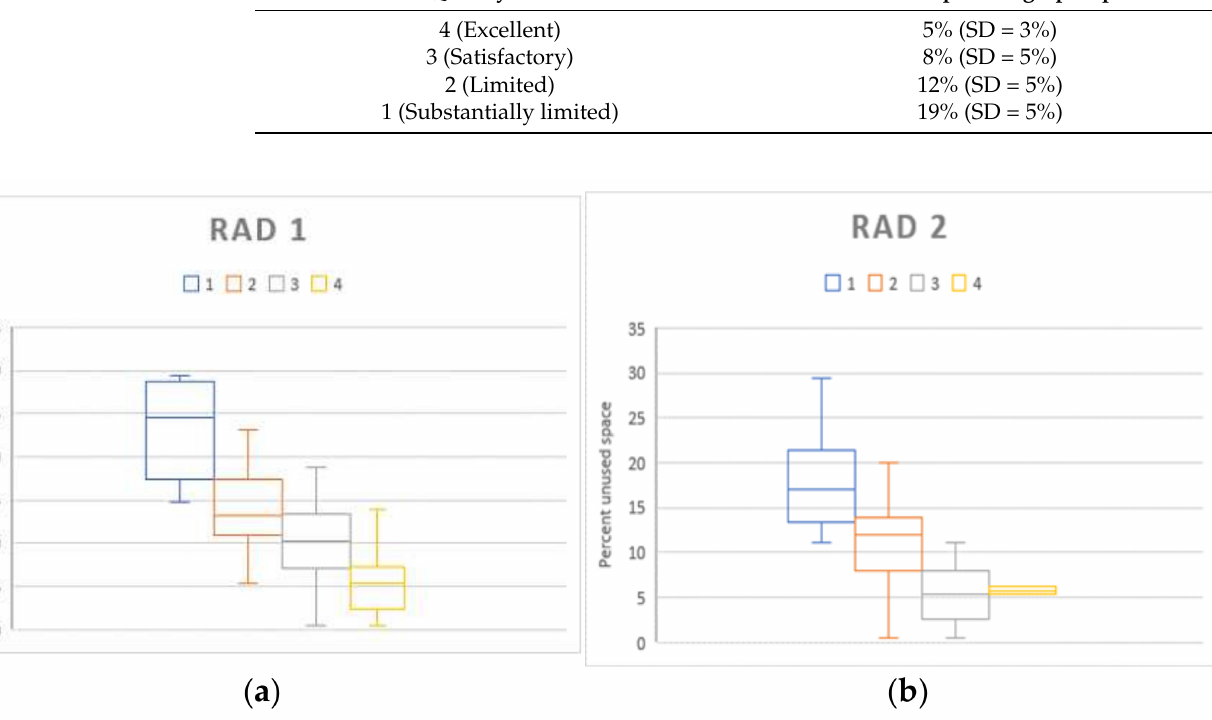
Figure 3. Boxplots demonstrating distribution of “top unused space percentages” as calculated by AI algorithm for different quality scores assigned by two radiologists ( a , b ). Quality score of “1” refers to “substantially limited”, “2” refers to “limited”, “3” refers to “satisfactory”, and “4” refers to “excellent” quality of